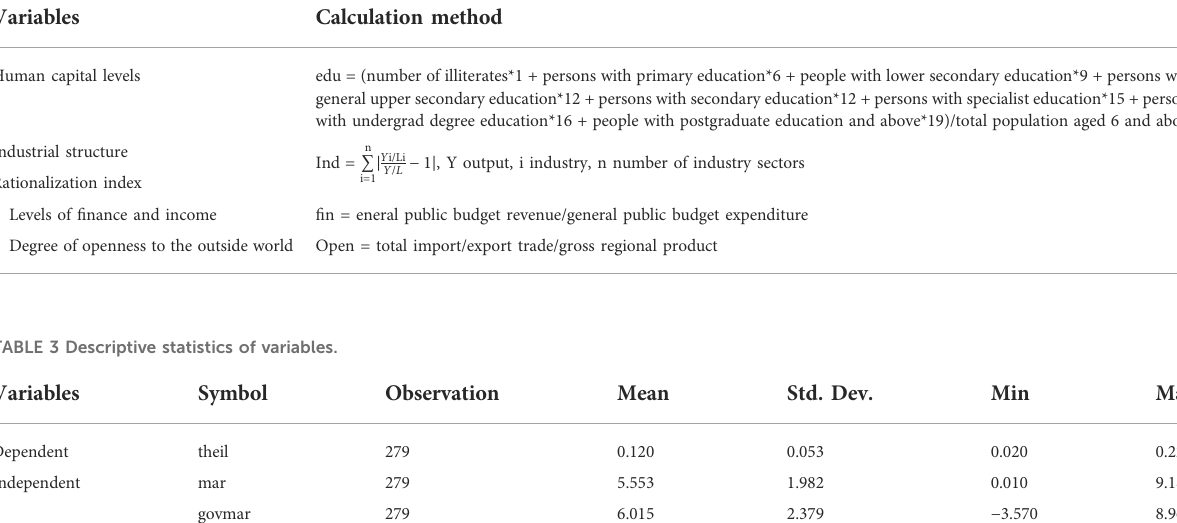
TABLE 2 Calculation of control variables.